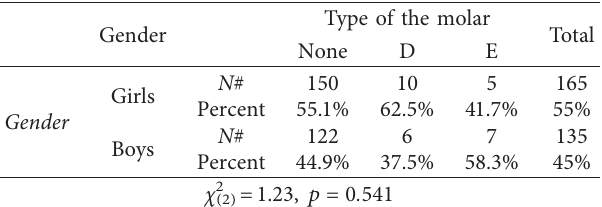
Table 2: Comparison of the frequency distribution of the type of three-rooted deciduous teeth in terms of side of the mandible.